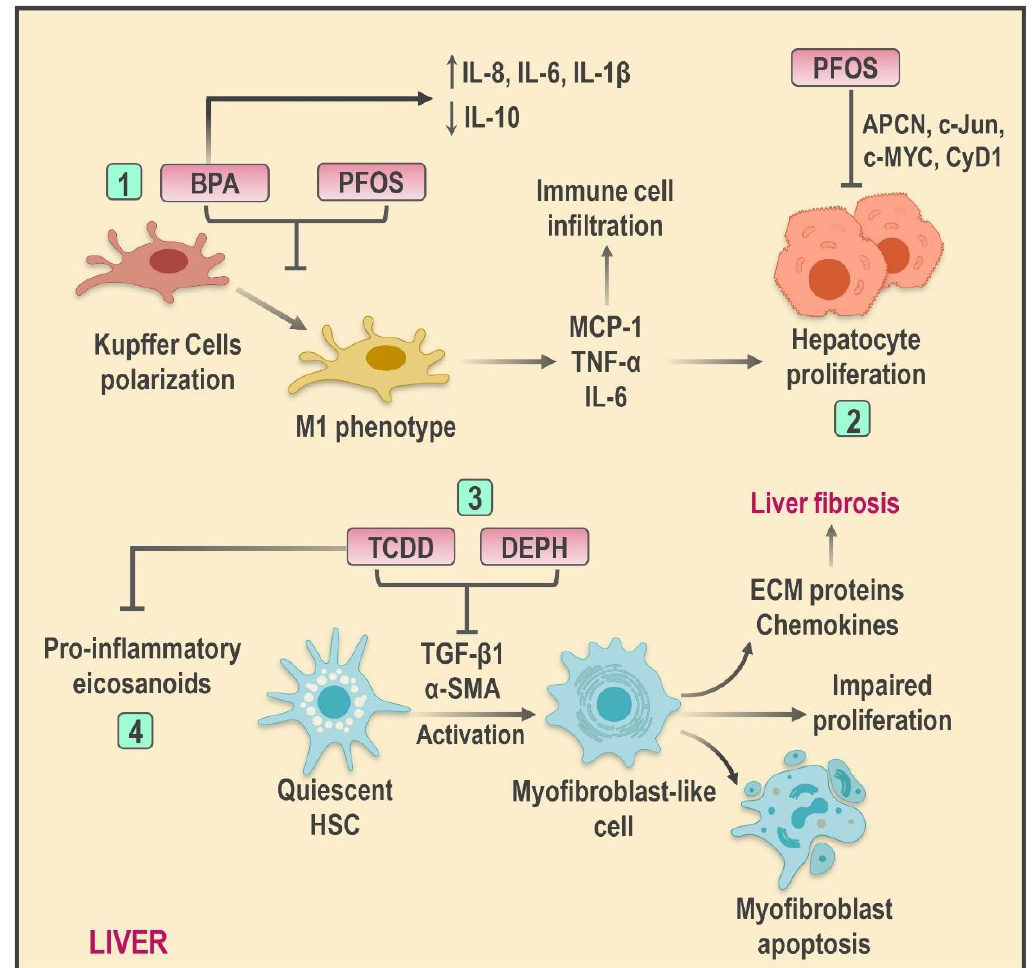
Figure 2. Schematic illustration of the effects of EDCs on hepatic inflammation and non-alcoholic steatohepatitis (NASH) progression. Several EDCs promote hepatic inflammation through diverse mechanisms, such as (1) induction of cytokine production and Kupffer cell polarization to a pro-inflammatory phenotype; (2) increased hepatocyte proliferation and immune cell infiltration; (3) HSC transformation to myofibroblast-like cell by promoting an imbalance between proliferation/apoptosis and, consequently, liver damage and fibrosis development; (4) increased pro-inflammatory eicosanoids production. Abbreviations: BPA: Bisphenol A; PFOS: Perfluorooctane sulfonate; DEPH: Di-(2-ethylhexyl)